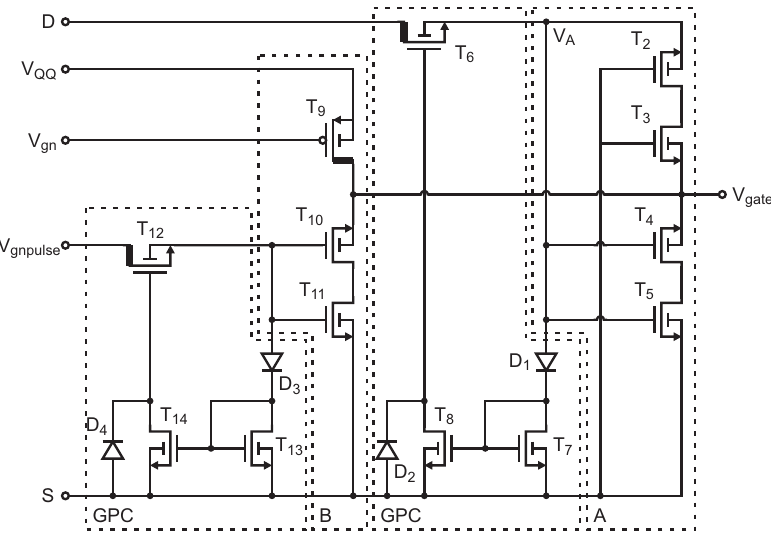
Figure 3. Schematic of the switch control block. Circuit A keeps the switch in the off state. Circuit B changes the state of the switch. GPC (Gate Protection Circuit) protects the gate of the switch from